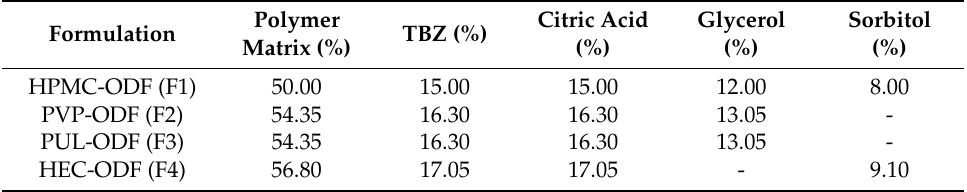
Table 2. Overview of orodispersible films (ODF) composition. HPMC: Hydroxypropylmethylcellulose; PVP: Povidone; PUL: Pullulan; HEC; Hydroxyethylcellulose. Citric Acid Glycerol Sorbitol Polymer TBZ (%) Formulation (%) (%) (%) Matrix (%) HPMC-ODF (F1) 50.00 15.00 PVP-ODF